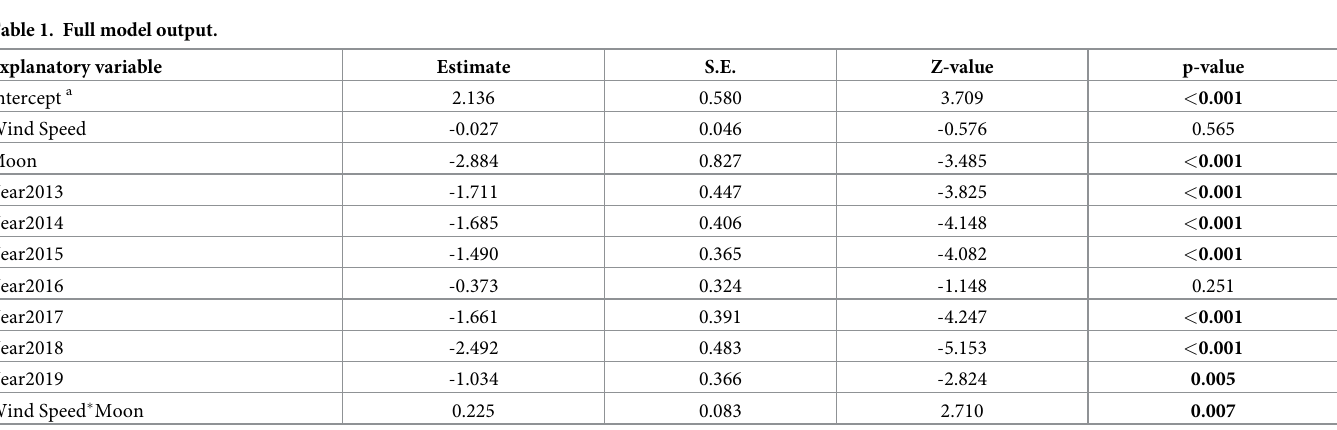
Table 1. Full model